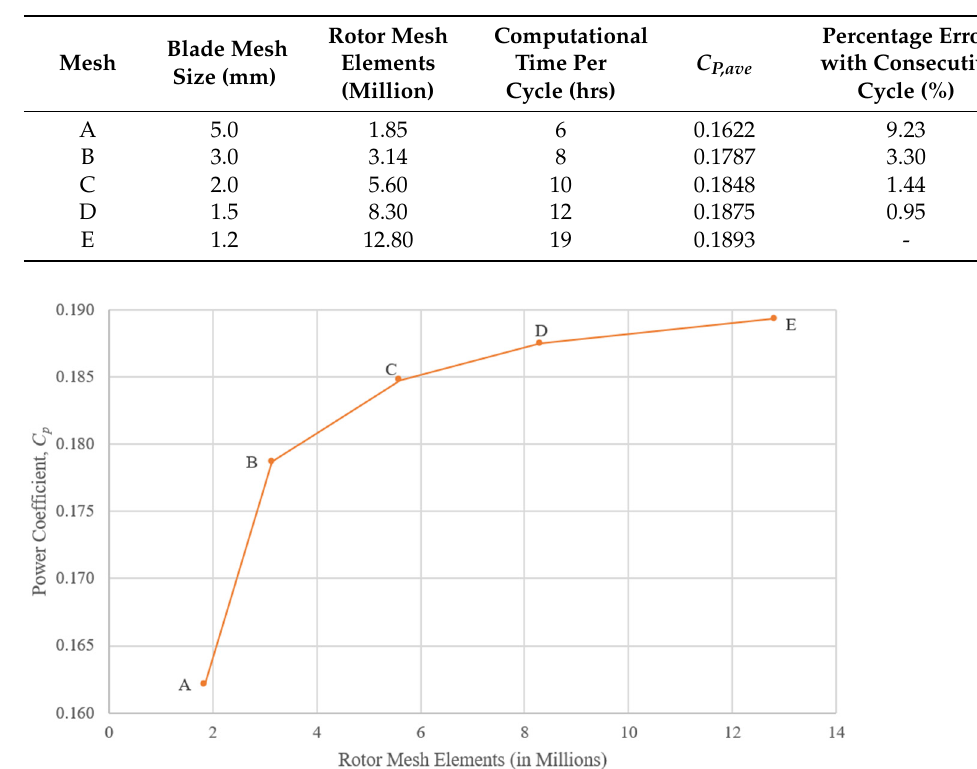
Table 2. Detail of meshes.